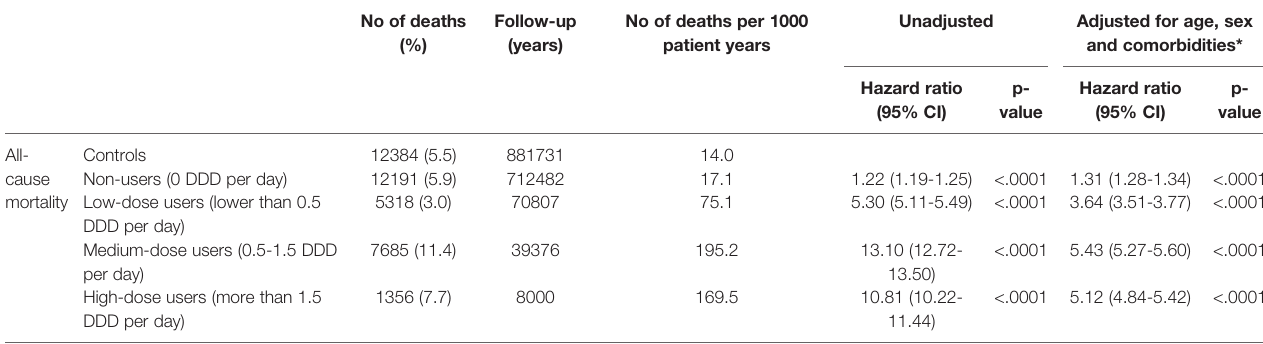
TABLE 4 | All-cause mortality in oral glucocorticoid (GC) users compared to age- and sex-matched controls.